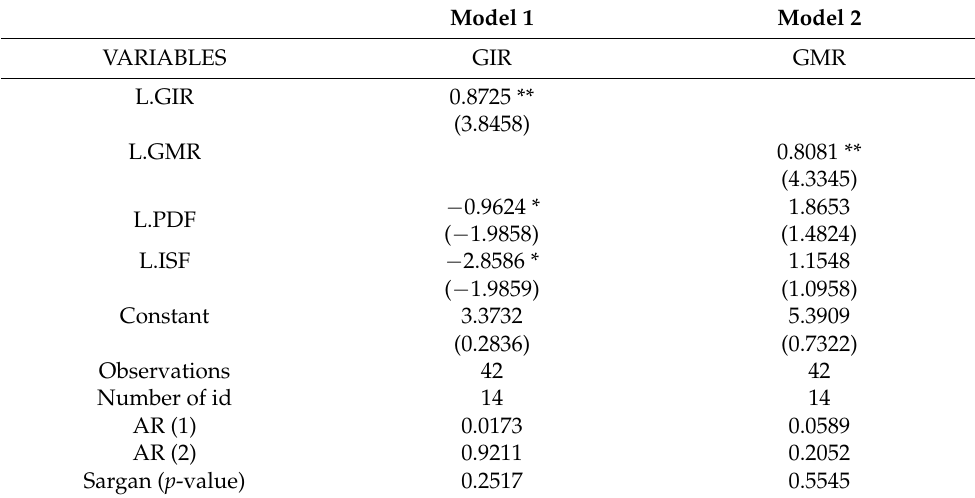
Table 7. Differential GMM regression